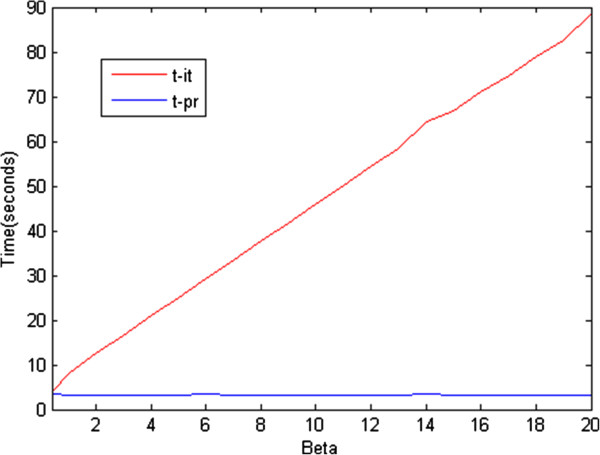
MAE of the iterative RLS (er-it), and proposed RLS (er-pr) methods for different sizes of
pO

2
maps used in the estimation ofLs−1.